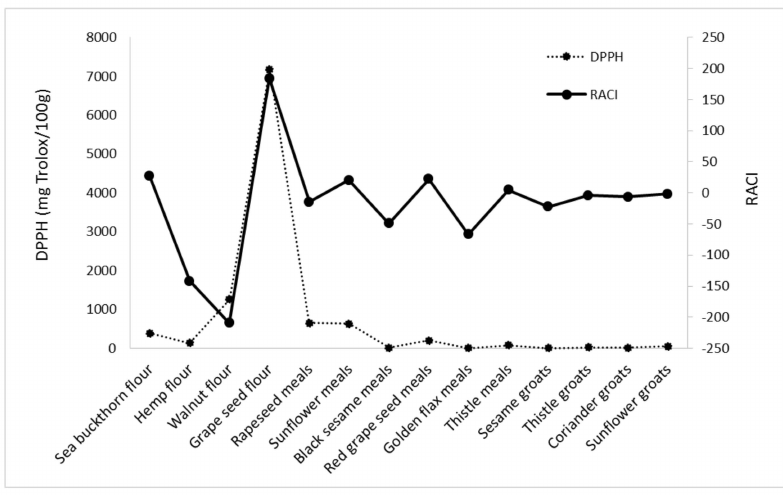
Figure 6. Correlation between RACI and DPPH